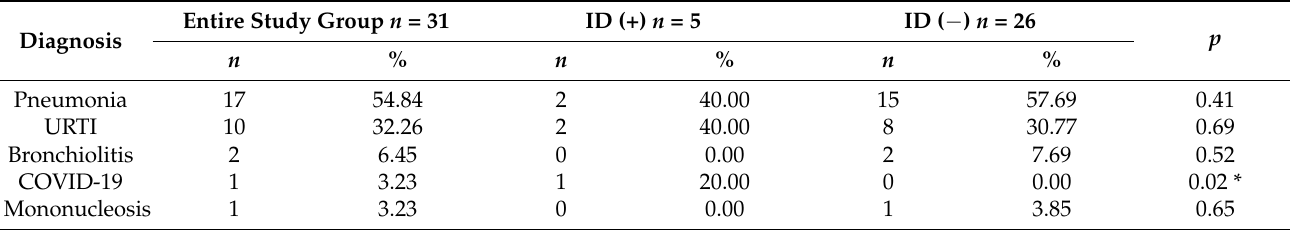
Table 3. Final diagnosis in children who had respiratory